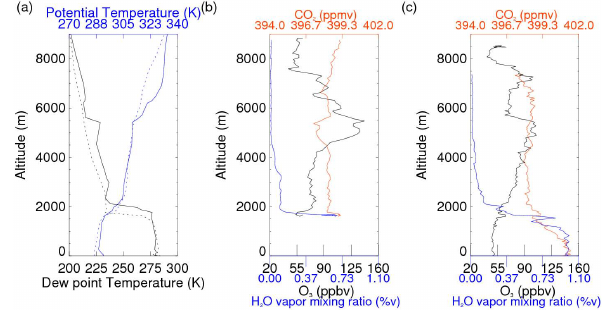
Fig. 3. (a) Potential temperature (blue) and dew point (black) sound- ings at Oakland, CA, on 14 May 2012 at 12:00UTC (dotted lines) and 15 May 2012 at 00:00UTC (solid lines). Oakland is ∼ 140km from the San Joaquin Valley (inland) site and ∼ 100km from the offshore site. Mixing ratios of O 3 (black), CO 2 (red) and H 2 O (blue) observed (b) offshore, and (c) over the San Joaquin Valley during vertical profiles on 14 May